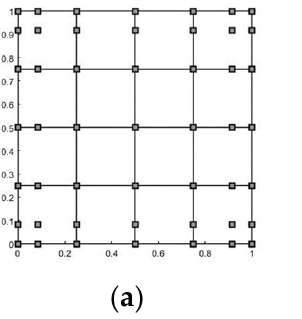
Figure 4. Three meshes of ( a ) 7 × 7 control points, ( b ) 11 × 11 control points, ( c ) 19 × 19 control points. Table 1. Convergence of dimensionless frequency and dimensionless critical buckling load of the FG-GRP plates with different control meshes.